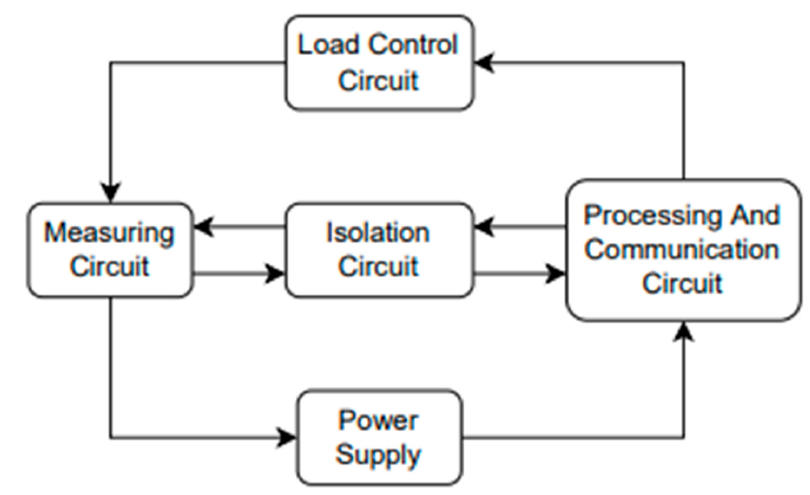
Figure 1. Hardware flowchart.